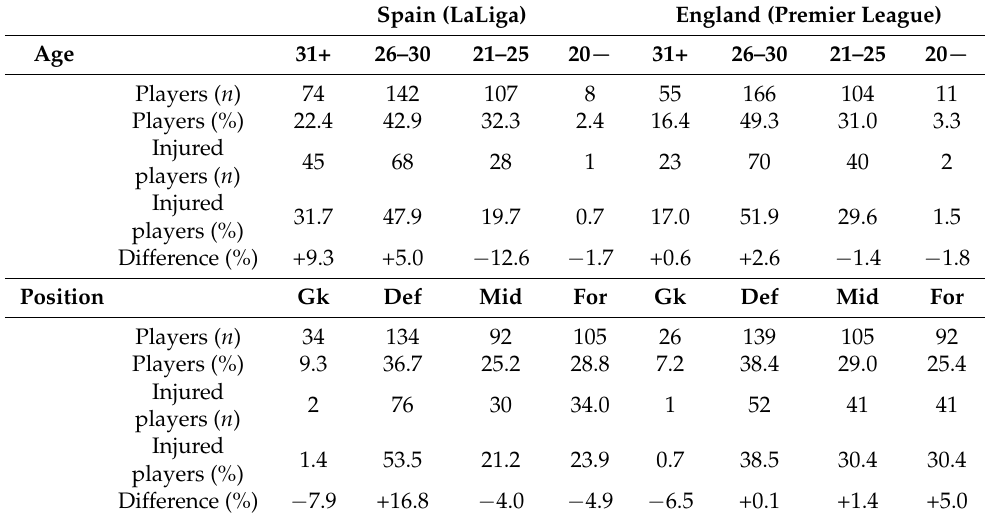
Table 2. Analysis of injuries by age and